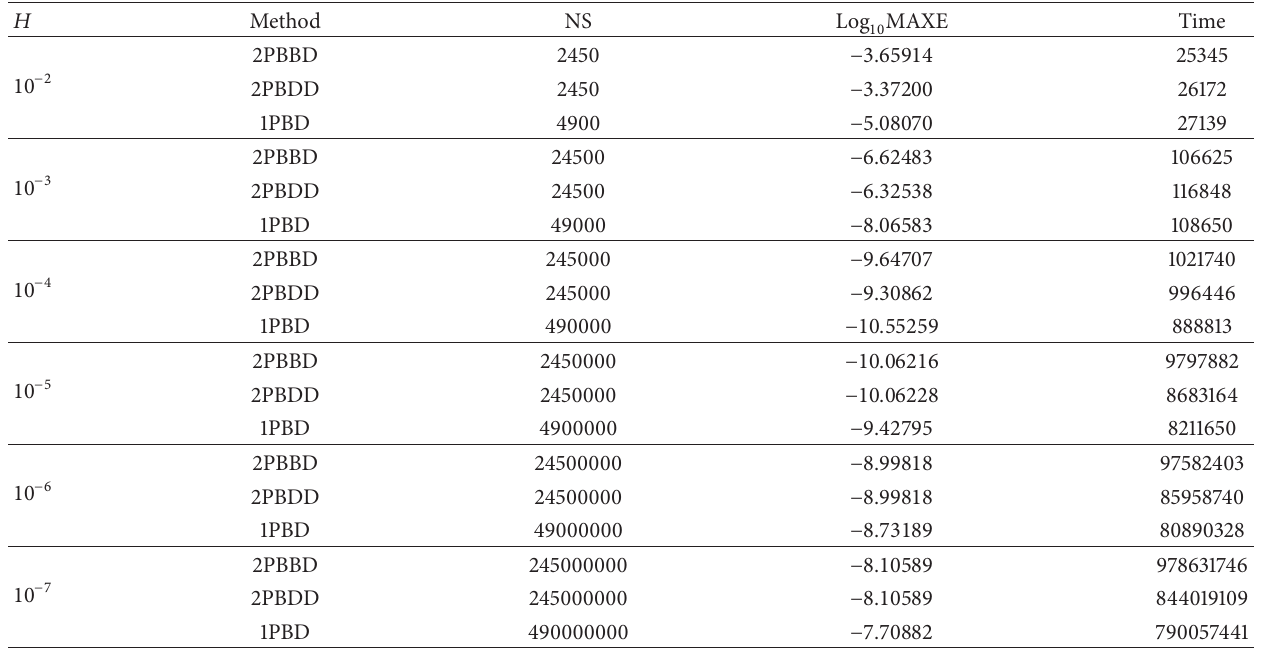
Table 8: Numerical result for Problem 5.